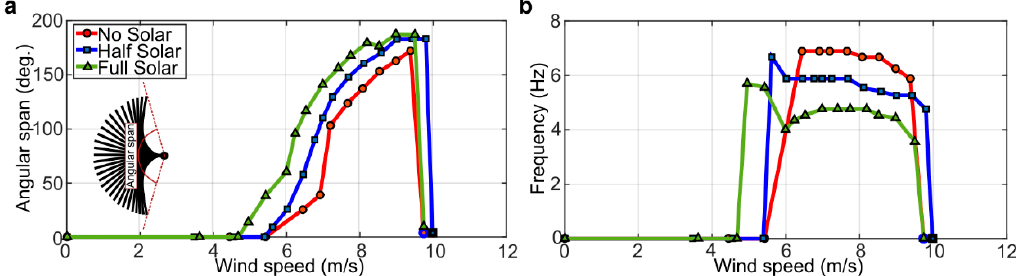
Figure 4. Experimental measurements of the dynamics of the inverted flags: ( a ) angular span of motion vs. wind speed; ( b ) dominant frequency of motion vs. wind speed.